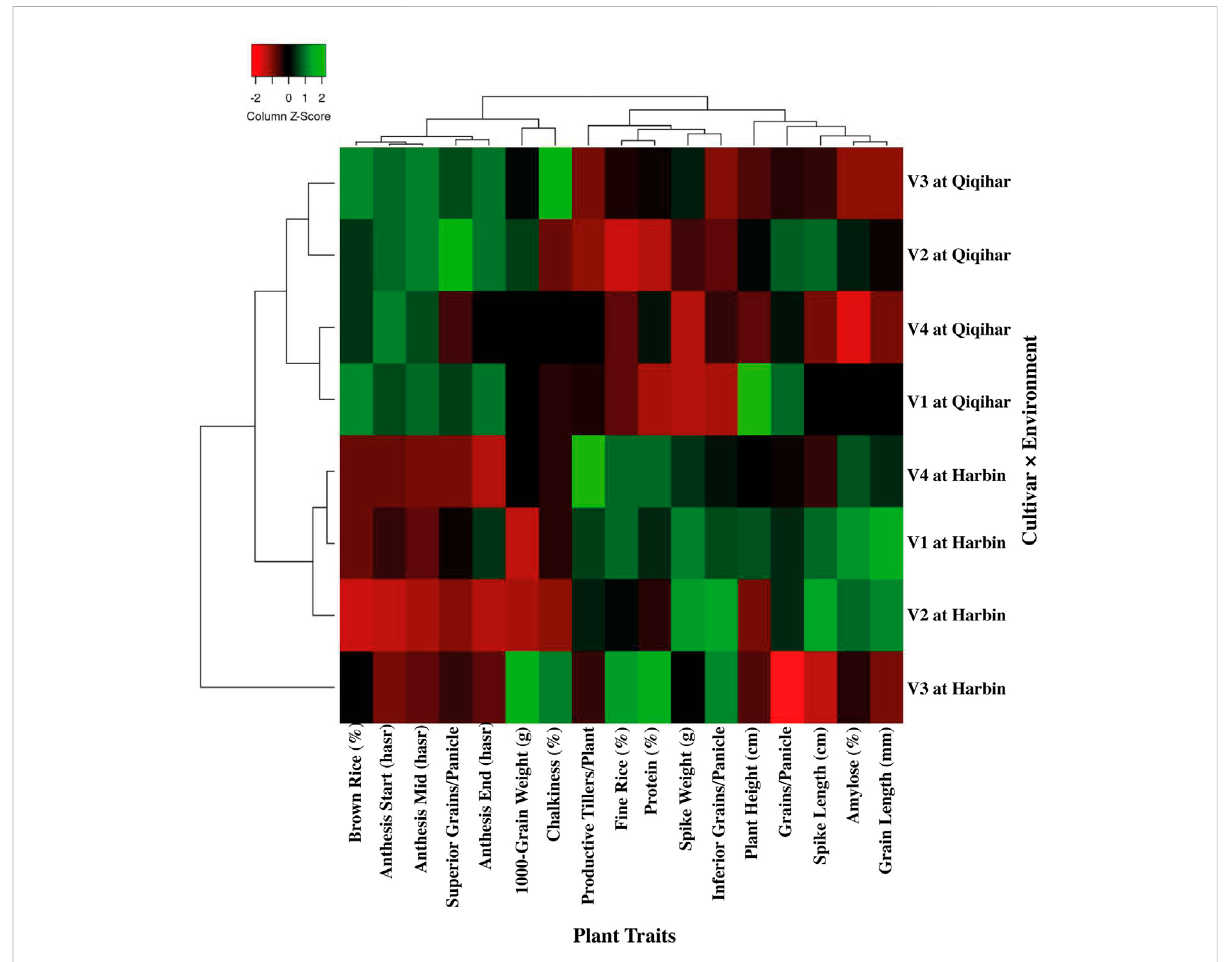
FIGURE 6 Heatmap describing the two-dimensional visualization of environment-by-trait through clustering of similar and different groups. The dendrogram differentiates the similarities between climatic conditions and plant